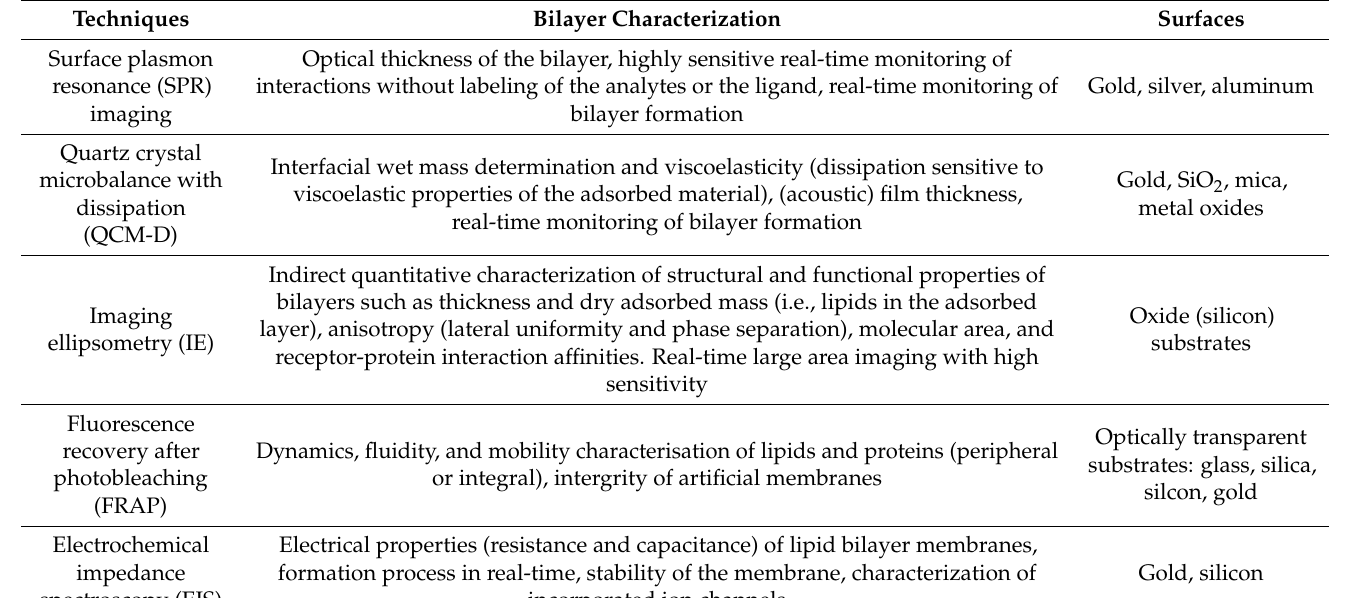
Table 1. Characteristics of main surface-sensitive analytical techniques useful for investigation of supported planar model membranes included tBLMs (adapted from